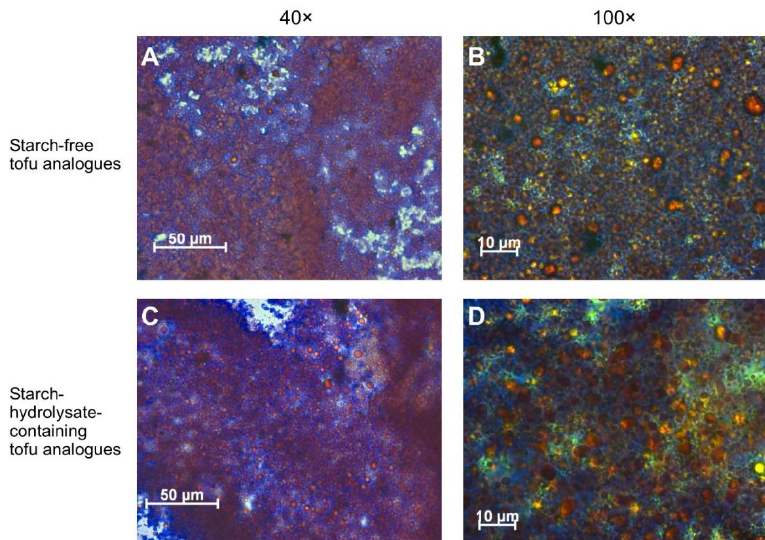
Figure 6. Microstructure of faba bean starch-free tofu analogues ( A and B ) and starch-hydrolysate- Figure6. Microstructureoffababeanstarch-freetofuanalogues( A , B )andstarch-hydrolysate-containing containing tofu analogues ( C and D ) observed in an optical microscope with 40× ( A and C ) and 100× tofu analogues ( C , D ) observed in an optical microscope with 40 × ( A , C ) and 100 × ( B , D ) objectives. ( B and D ) objectives. The lipids were stained red by Oil red O and the proteins were stained blue The lipids were stained red by Oil red O and the proteins were stained blue using Coomassie using Coomassie Brilliant Blue. Brilliant